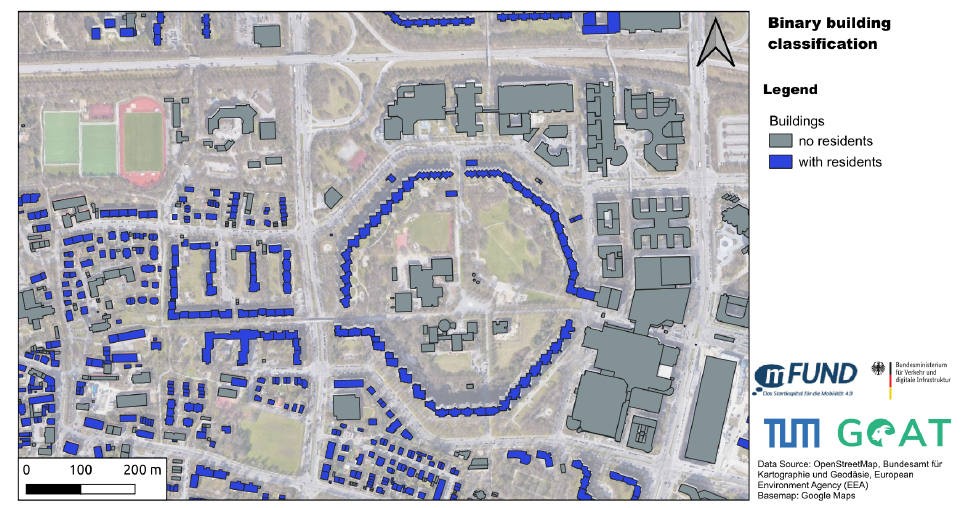
Figure 9. Binary classification buildings.